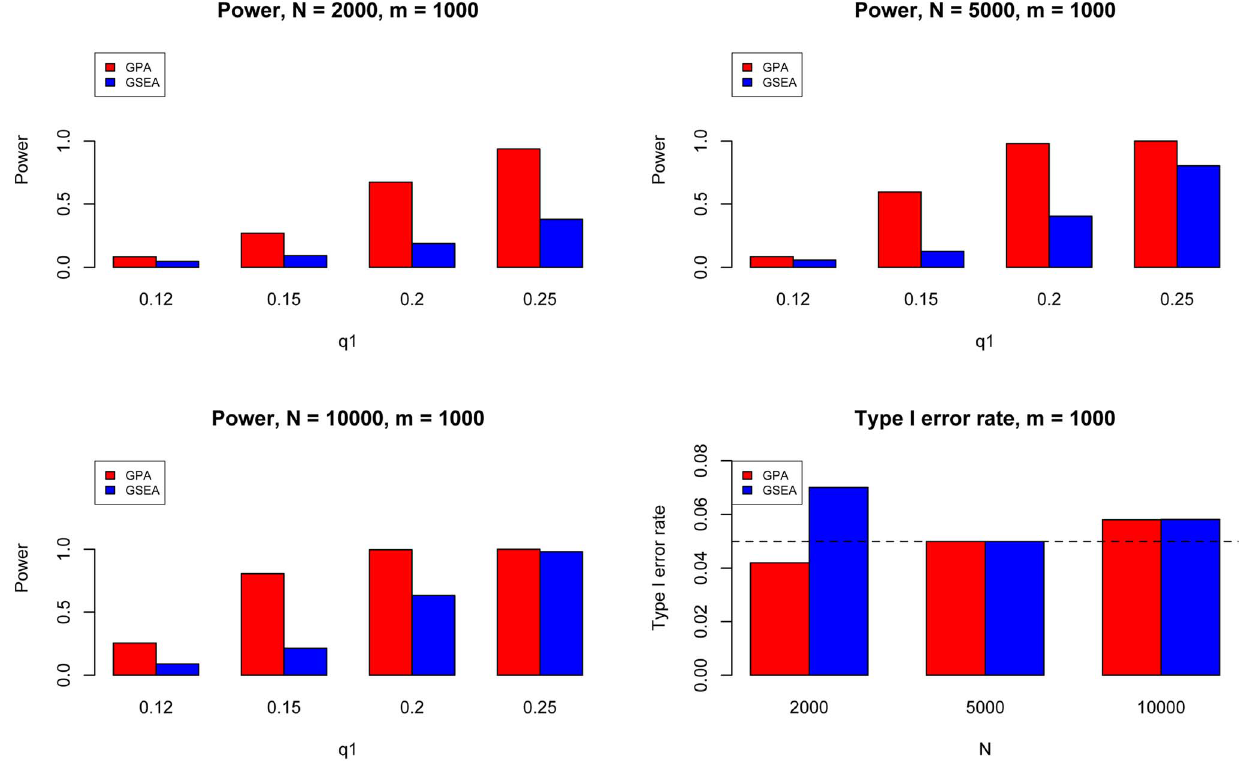
Figure 4. The comparison between GPA and GSEA at number of risk SNPs m =1000. Here we fixed q 0 ~ 0 : 1 and varied q 1 ~ 0 : 12,0 : 15,0 : 2,0 : 25 to evaluate the power for sample size N =2000 (Upper Left panel), 5000 (Upper Right panel), 10000 (Lower Left panel), respectively. We used q 0 ~ q 1 ~ 0 : 1 to evaluate the type I errors (Lower Right panel). The results are based on 500